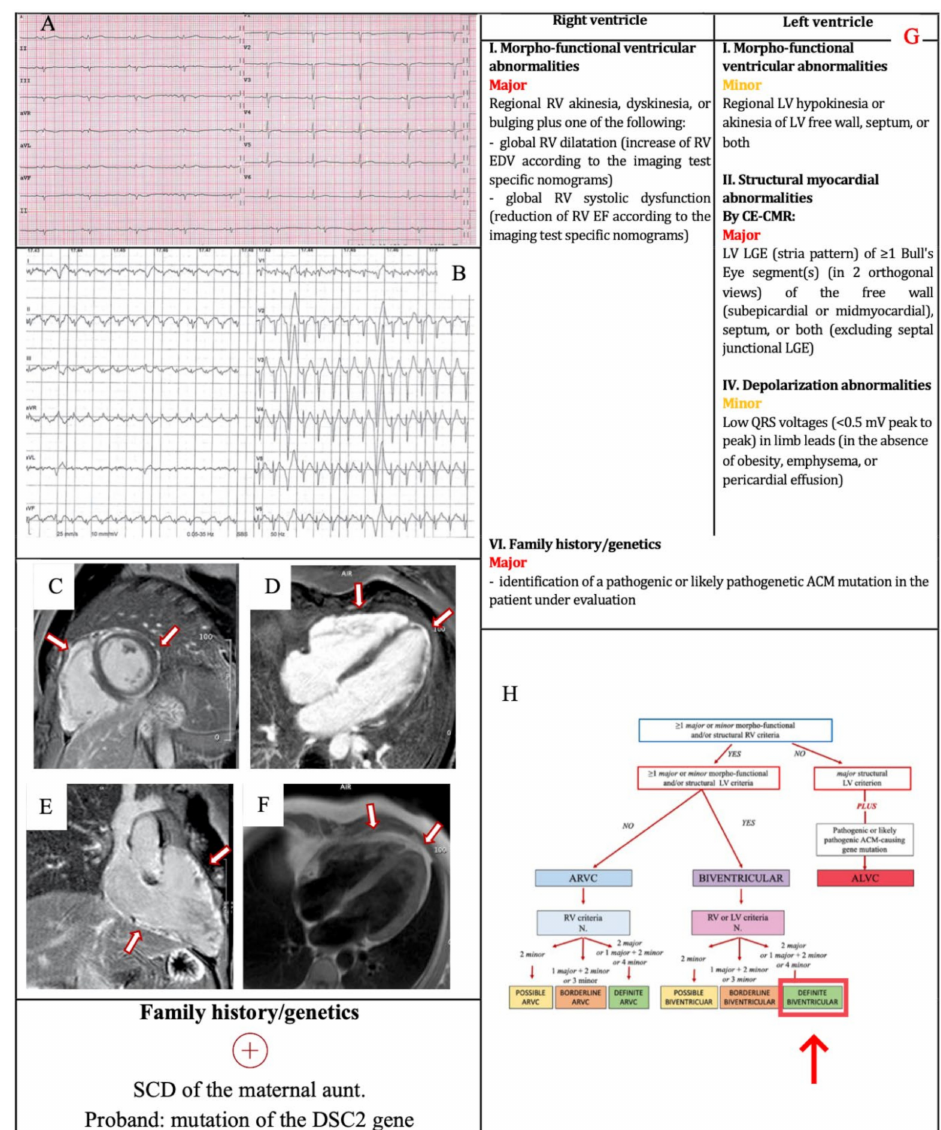
Figure 3. Example 2. ( A ) ECG. Low QRS voltages in limb leads and flattened T wave in infero-lateral leads. ( B ) Exercise testing. 2 PVBs with LBBB with negative precordial concordance/right axis deviation morphology. CMR. Postcontrast phase, short axis view ( C ), four-chamber view ( D ), RV inflow–outflow view ( E ): LGE of LV and RV (arrows). PD–TSE four-chamber view ( F ): fatty infiltra- tion (arrows). The 2020 Padua criteria achieved by the patient ( G ). Diagnostic flowchart for ACM phenotypic variants [12] ( H ). In the red box, the diagnosis of the patient. CMR = cardiac magnetic resonance; DSC2 = Desmocollin-2; LBBB = left bundle branch block; LGE = late gadolinium enhance- ment; LV = left ventricle; PD–TSE = proton density-weighted turbo spin-echo; PVBs = premature ventricular beats; RV = right ventricle; SCD = sudden cardiac